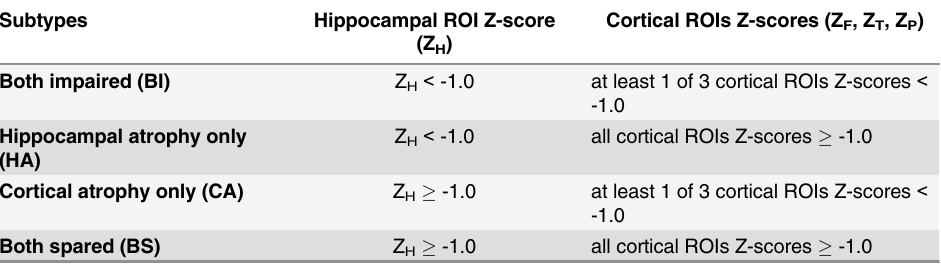
Table 1. Classification algorithm based on regional atrophy patterns and definition of